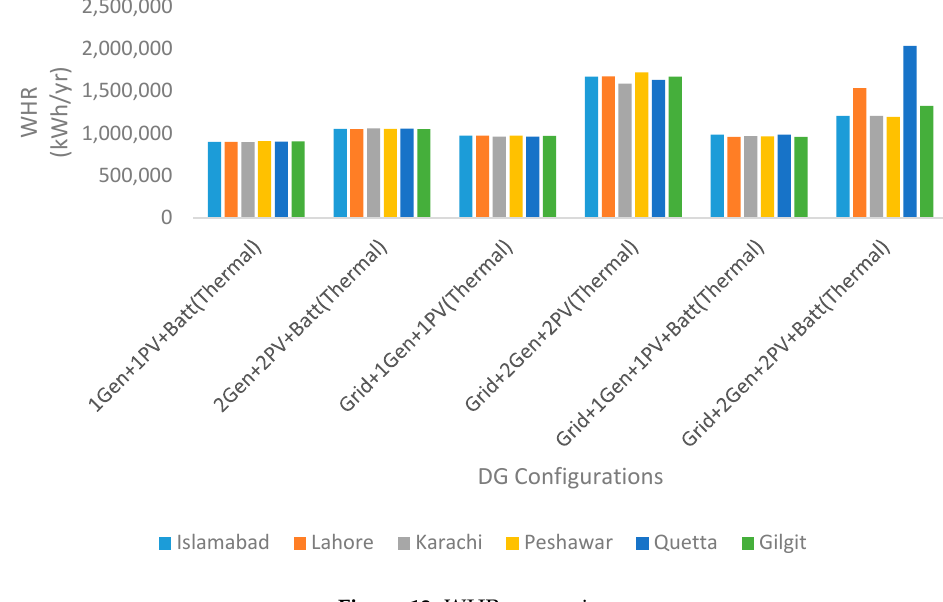
Figure 13. WHR comparison.